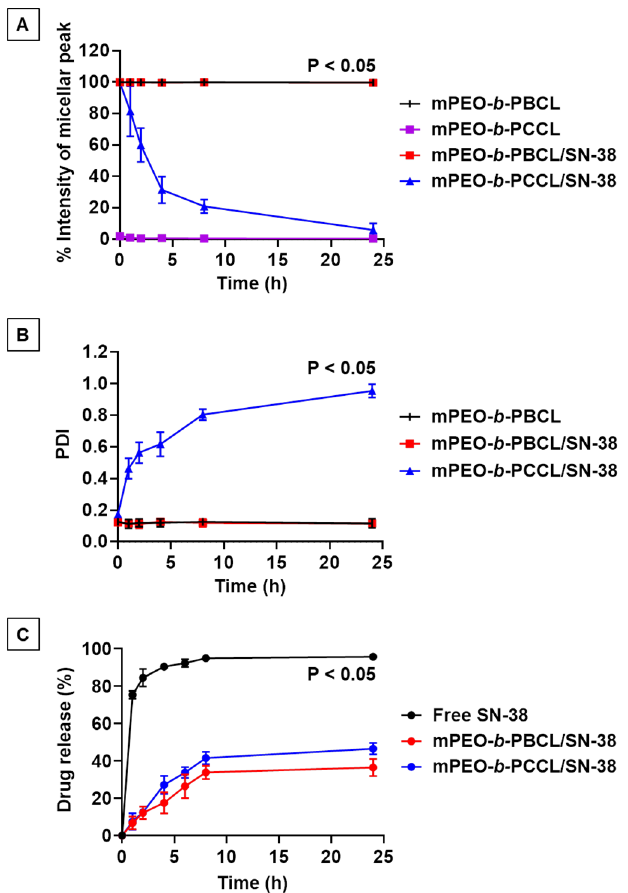
Figure 4. Average ( A ) percentage of intensity and ( B ) polydispersity index (PDI) of mPEO- b -PBCL, mPEO- b -PBCL/SN-38, mPEO- b -PCCL (no PDI data), and mPEO- b -PCCL/SN-38 micellar peak (3 mg·mL − 1 ) in the presence of SDS (20 mg·mL − 1 ) at a ratio of 2:1 ( v/v ) as a function of time up to 24 h. Each point represents mean ± SD ( n = 3). ( C ) The drug release profile of mPEO- b -PBCL/SN-38 and mPEO- b -PCCL/SN-38 micelles compared to free SN-38 from dialysis tubing (MWCO = 3.5 kDa) in aqueous solution (4% albumin in ultrapure water) at 37 °C. Data are represented as mean ± SD ( n = 3). The results of statistical analysis using one-way ANOVA followed by Tukey’s method showed a significant difference between PEO- b -PBCL and mPEO- b -PCCL, between mPEO- b -PBCL/SN-38 and mPEO- b -PCCL/SN-38 in Figure 4A, between mPEO- b -PCCL/SN-38 and PEO- b -PBCL, between mPEO- b -PCCL/SN-38 and mPEO- b -PBCL/SN-38 in Figure 4B, and between free SN-38 and mPEO- b -PBCL/SN-38, between free SN-38 and mPEO- b -PCCL/SN-38 in Figure 4C. Significances of the